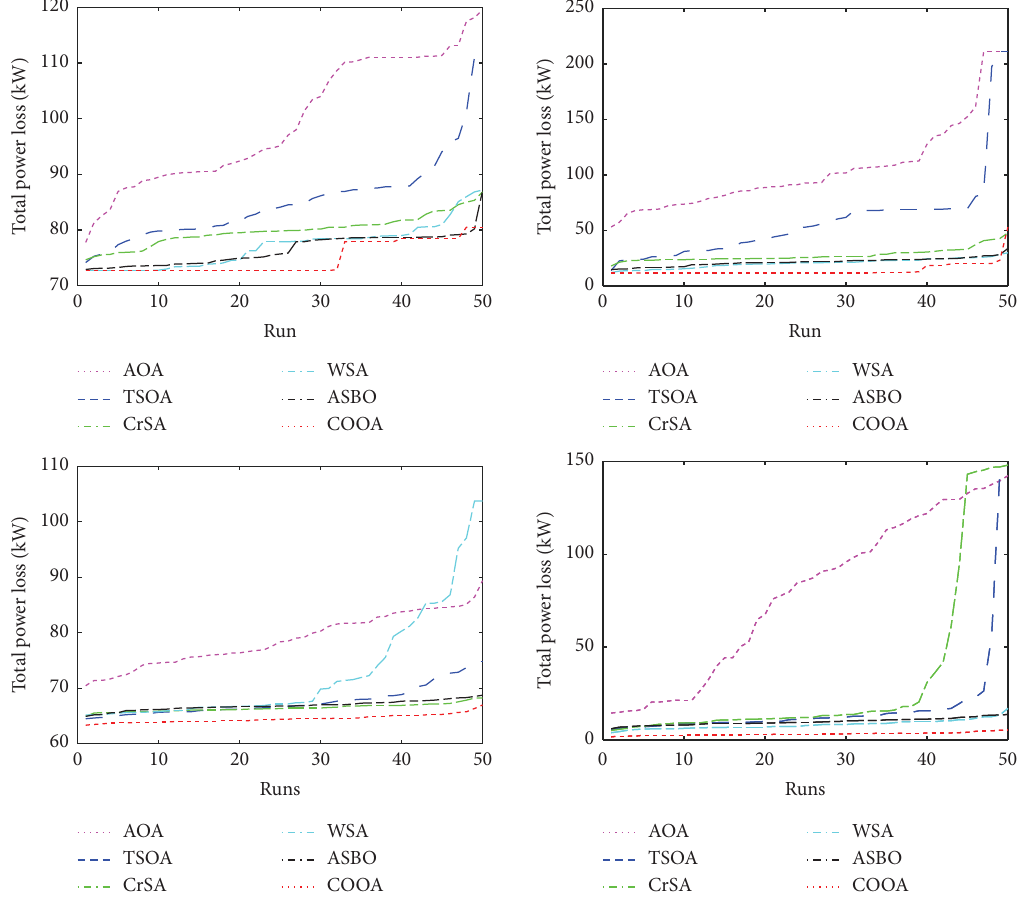
Figure 4: Loss values of ffty runs were obtained by applying the method to four cases of system